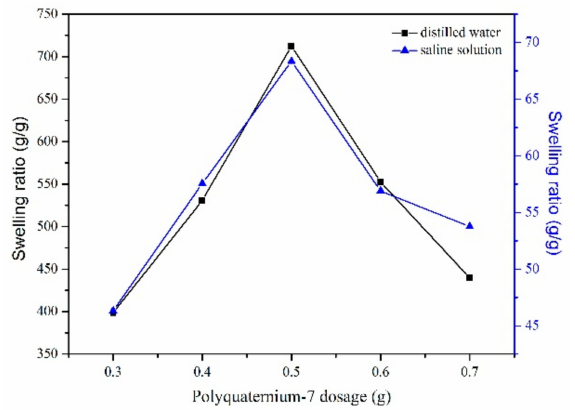
Figure 2. Effect of PQ7 dosage on the